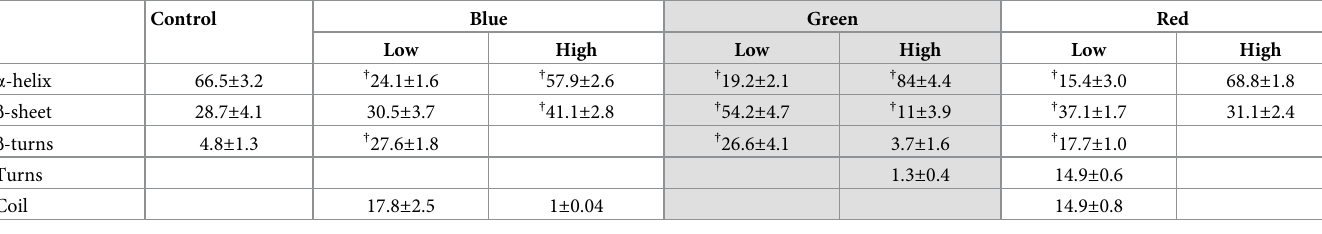
Table 3. The area percentage of protein secondary structure components due to exposure to different